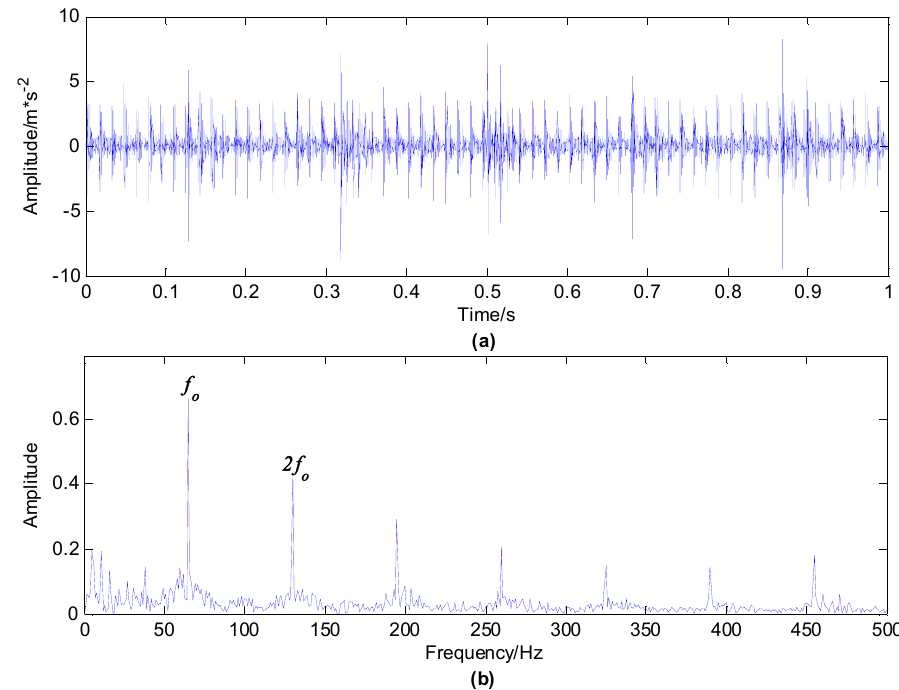
Figure 7. Rolling bearing signal with outer race and rolling element compound fault: ( a ) time waveform; ( b ) envelope spectrum.